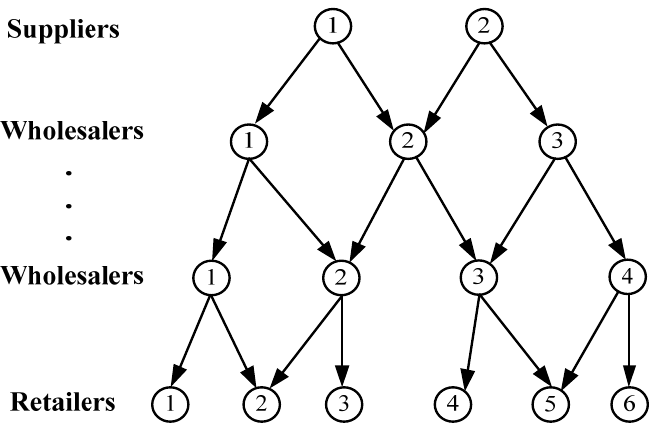
Figure 1. A traditional distribution system for retailing.